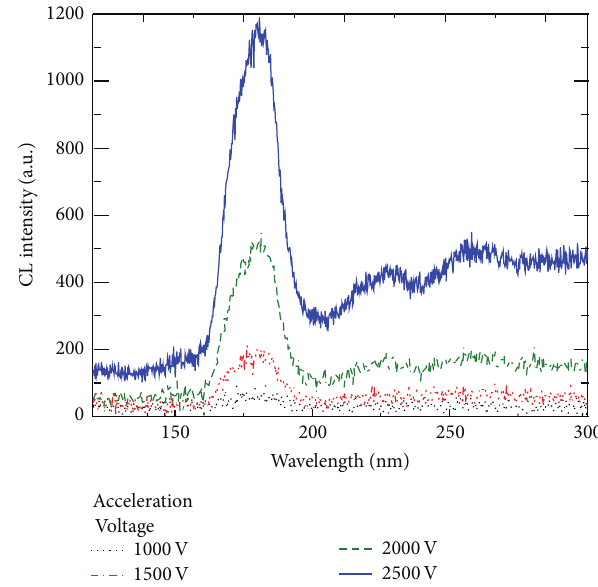
Figure 2: CL spectra of the Nd 3+ : LuF 3 thin film at acceleration voltages ranging from 1 to 20kV.